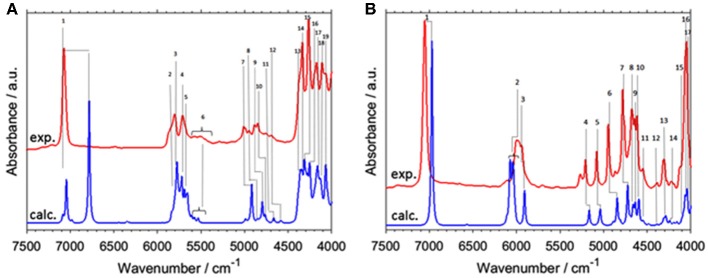
Experimental (0.2 M; CCl4) and simulated (VPT2//B3LYP/SNST+CPCM) NIR spectra of (A) cyclohexanol and (B) phenol. Reprinted with permission from Elsevier (Beć et al., 2018a).